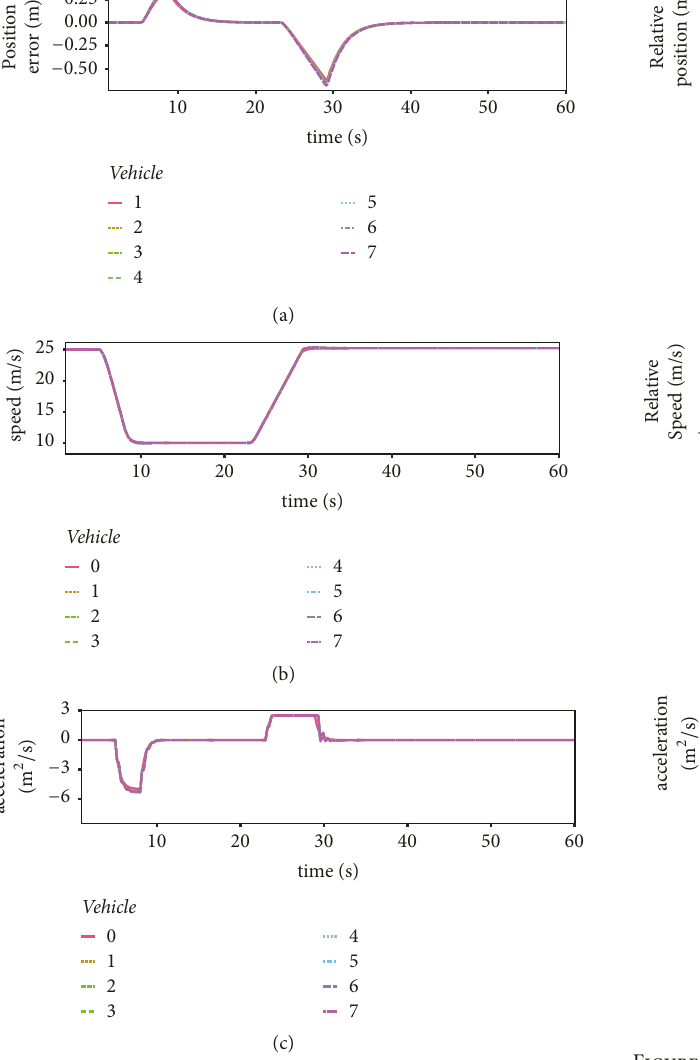
Figure 4: Platoon performance for the sinusoidal disturbance scenario: (a) the relative position 𝑥 𝑖−1 (𝑡) − 𝑥 𝑖 (𝑡) + 𝑠 ; (b) the relative speed V 𝑖−1 (𝑡) − V 𝑖 (𝑡) ; (c)